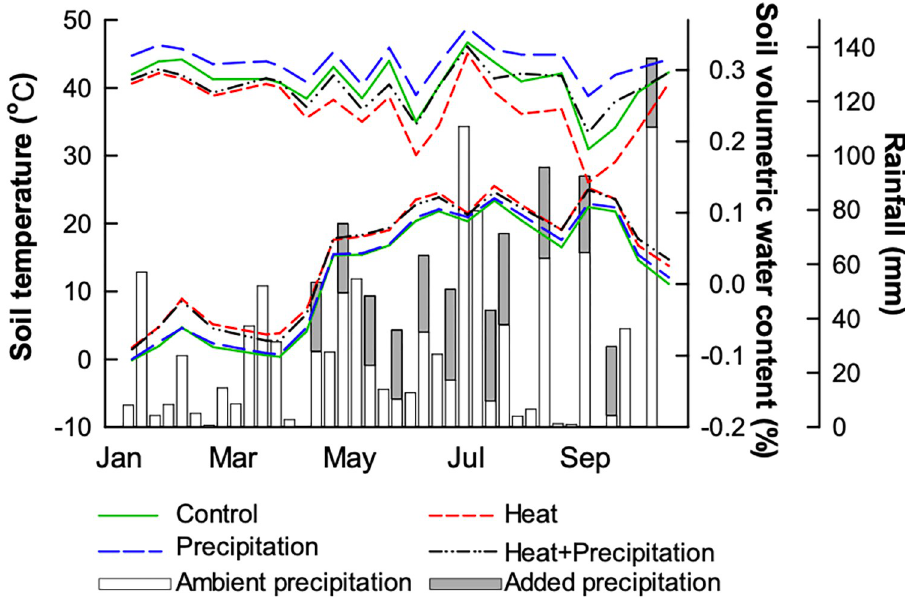
Fig 1. Soil moisture (upper lines) and soil temperature (lower lines; both taken at 5 cm depth) in climate treatments during 2013, as well as ambient precipitation received at the site and amounts of added precipitation applied to the +precipitation